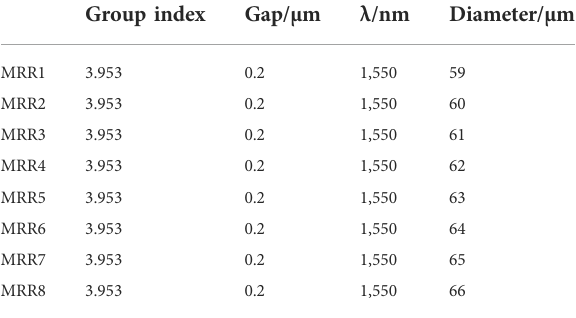
TABLE 2 Design parameters of the MRR.